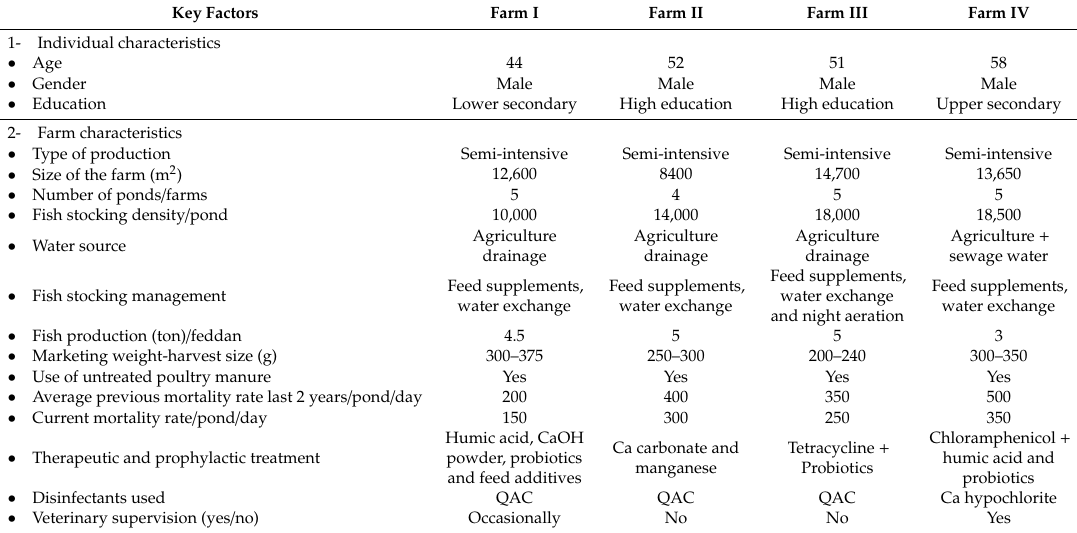
Table 1. The key characteristics of the examined fish farms at Kafrelshiekh province,